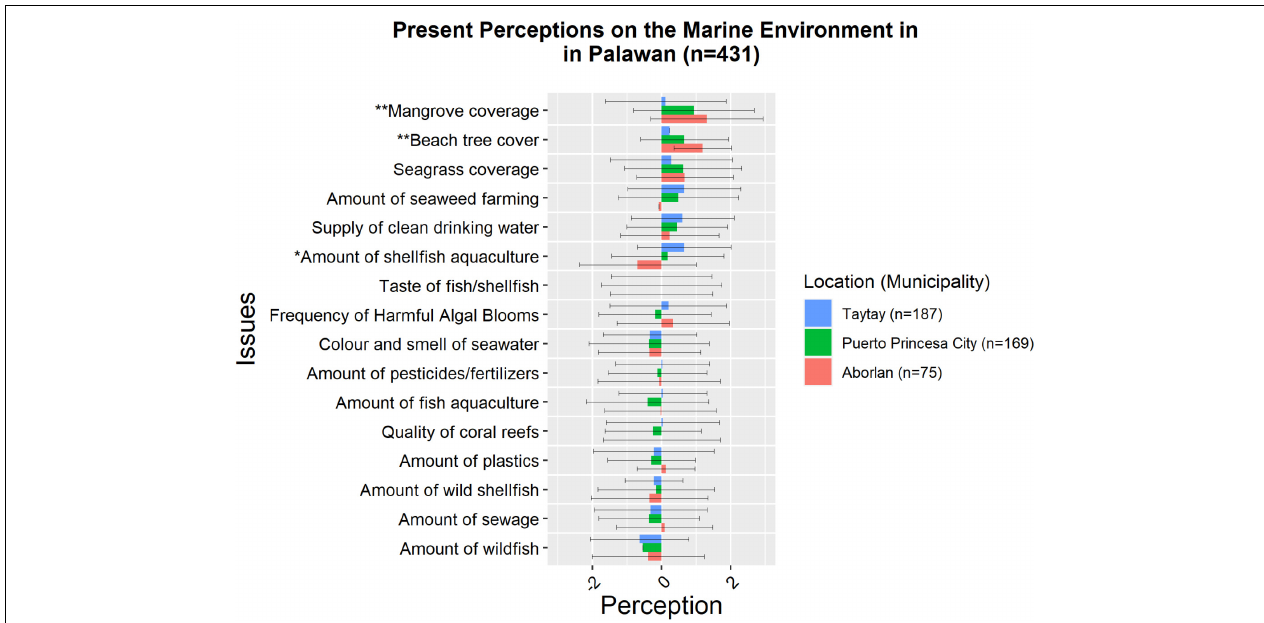
FIGURE 3 | Present perceptions across different locations. Issues with ** are areas where high significant differences were observed ( p < 0.01). Issues with * are areas where significant differences were observed ( p <